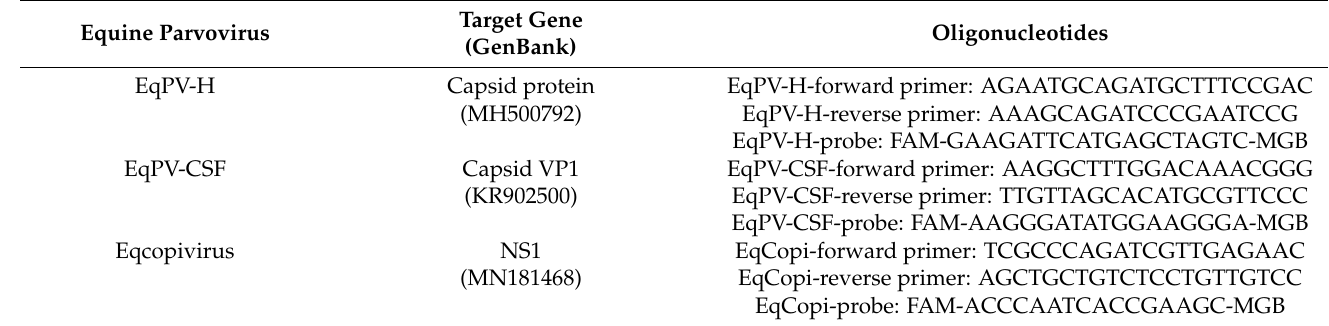
Table 1. Oligonucleotide sequences of primers and probes used to detect three newly identified equine parvoviruses by qPCR. Target Equine Parvovirus